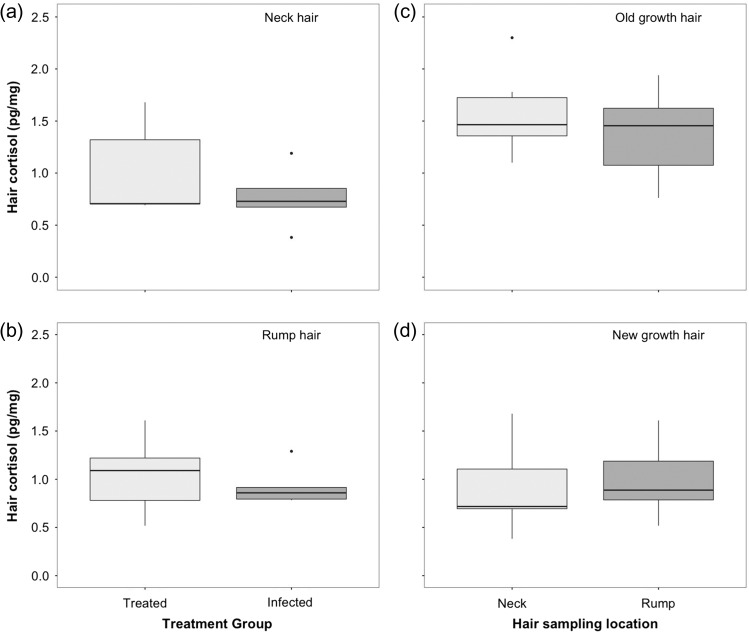
There was no significant difference in hair cortisol levels (in picograms per milligram) from hair collected from the neck (a) or rump (b) between treated (light boxes) and infected reindeer (dark boxes) or between hair collected from the neck (light boxes) or rump (dark boxes) in old-growth (c) or new-growth hair (d).